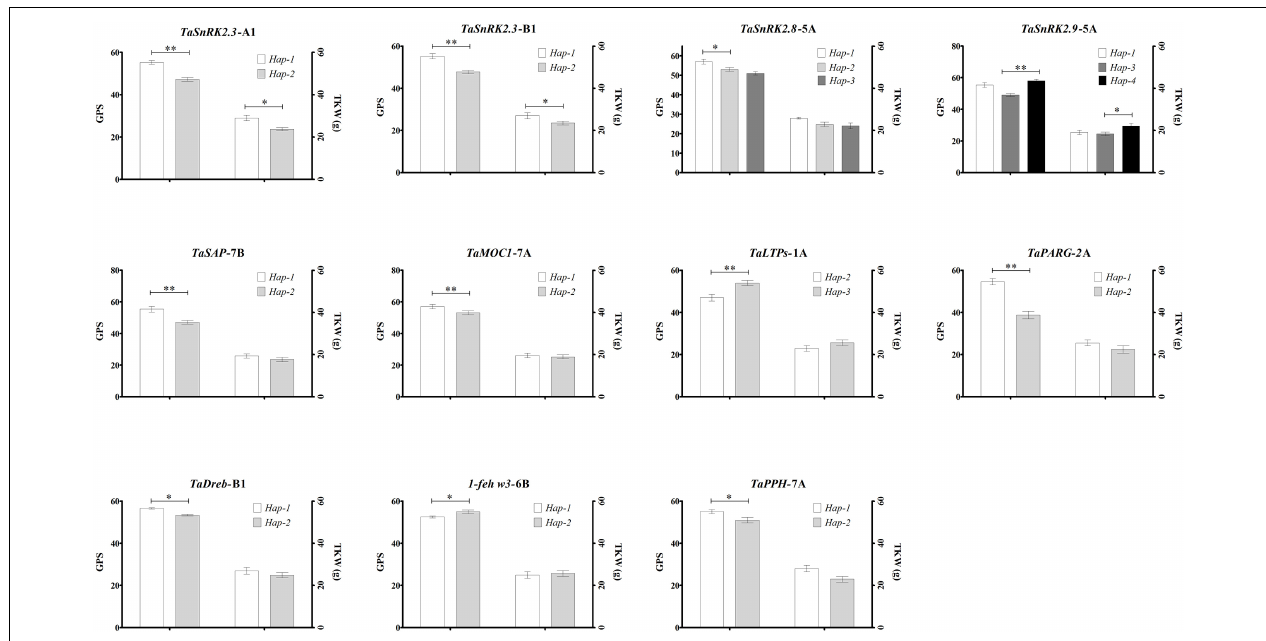
FIGURE 2 | Phenotypic comparison of allelic variations. Traits are thousand kernel weight—TKW, grains per spike—GPS, and plant height—PH. ∗ P < 0.05, ∗∗ P < 0.01. Error bar denotes standard deviation.